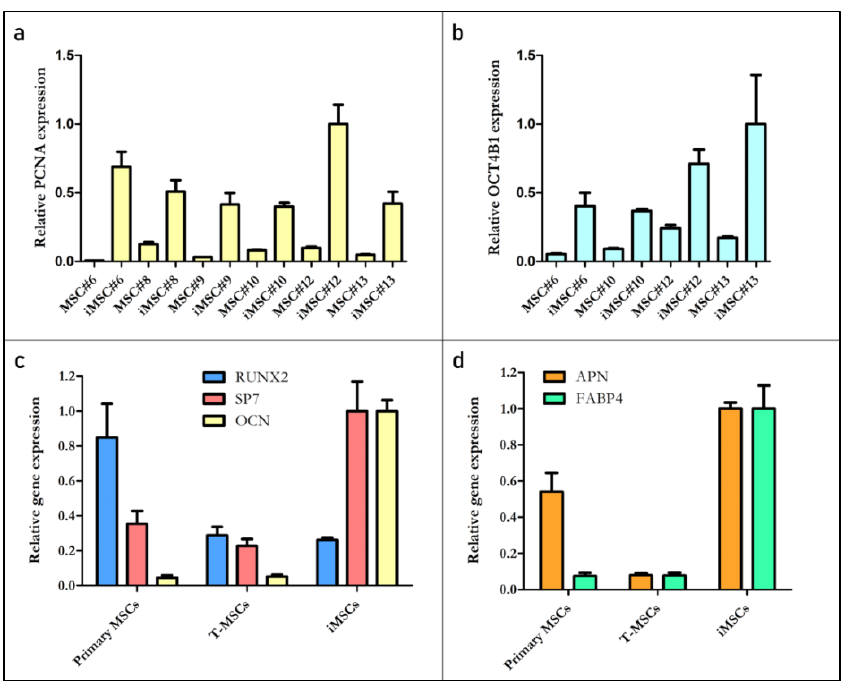
Figure 6. Relative expression levels (RELs) of PCNA ( a ) and OCT4B1 ( b ) in primary and immortalized undifferentiated MSCs. RELs of genes related to osteogenesis ( c ) and adipogenesis ( d ) in primary MSCs, T-MSCs and iMSCs for cell line #12. Information from primary MSC#13 and T-MSC#13 could not be obtained due to cell number